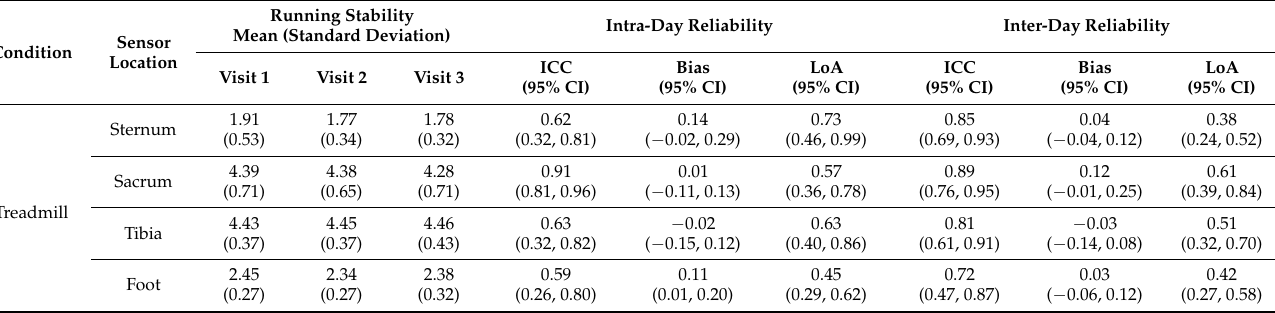
Table 2. Results of the running stability measurements for each of the three visits, intra-, and inter-day reliability metrics. ICC, intraclass correlation coefficient; CI, confidence interval; LoA, Bland–Altman’s limits of